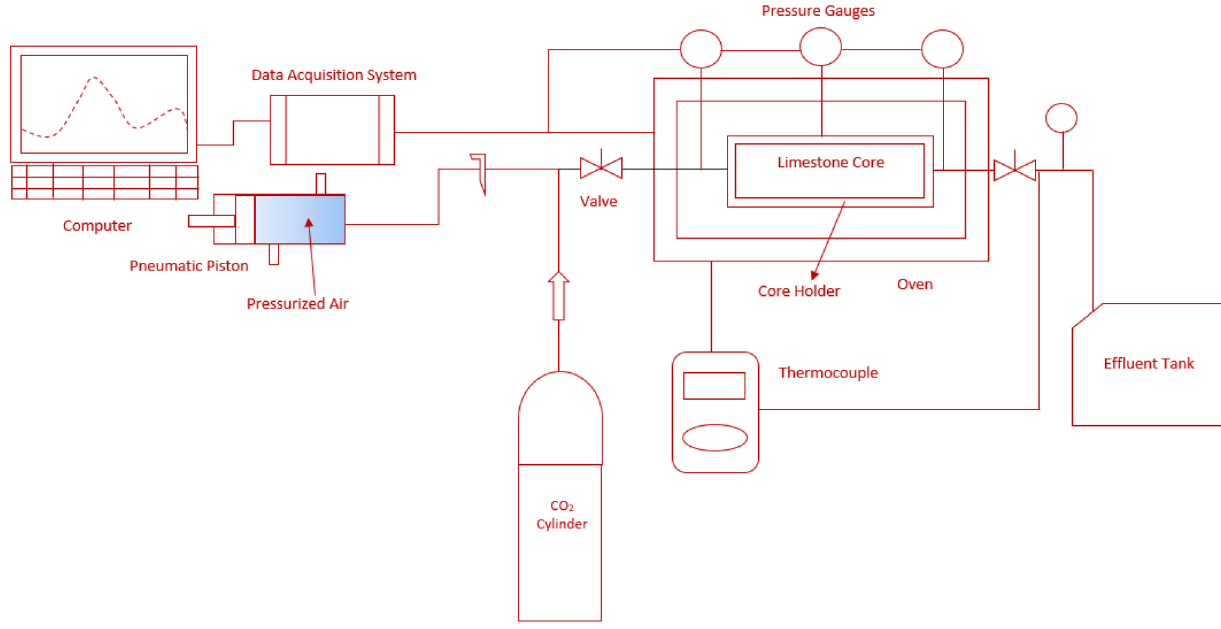
Fig. 3 Schematic diagram of experimental